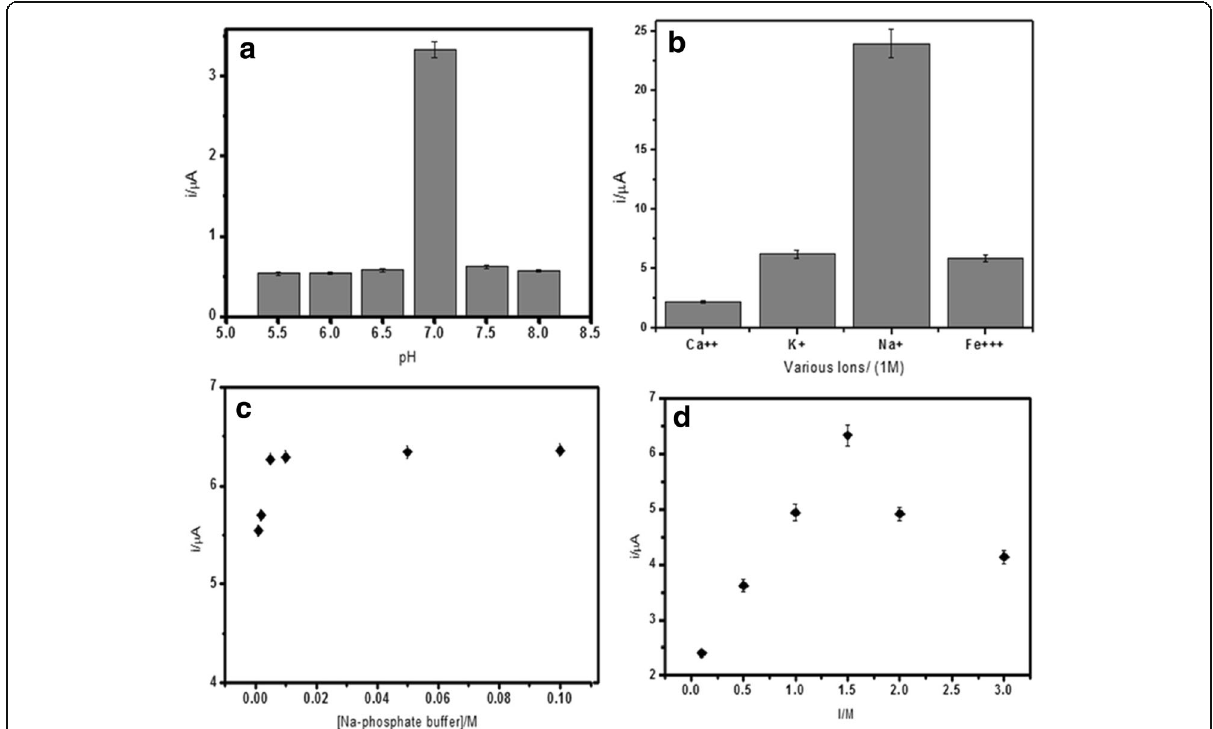
Fig. 5 The effect of pH ( a ) various cations ( b ), buffer concentration ( c ), and ionic strength ( d ) on the DNA hybridization response of the electrochemical V. cholerae DNA biosensor. Hybridization was performed with 5 μ M cDNA and reporter probe followed by intercalation with 1 mM